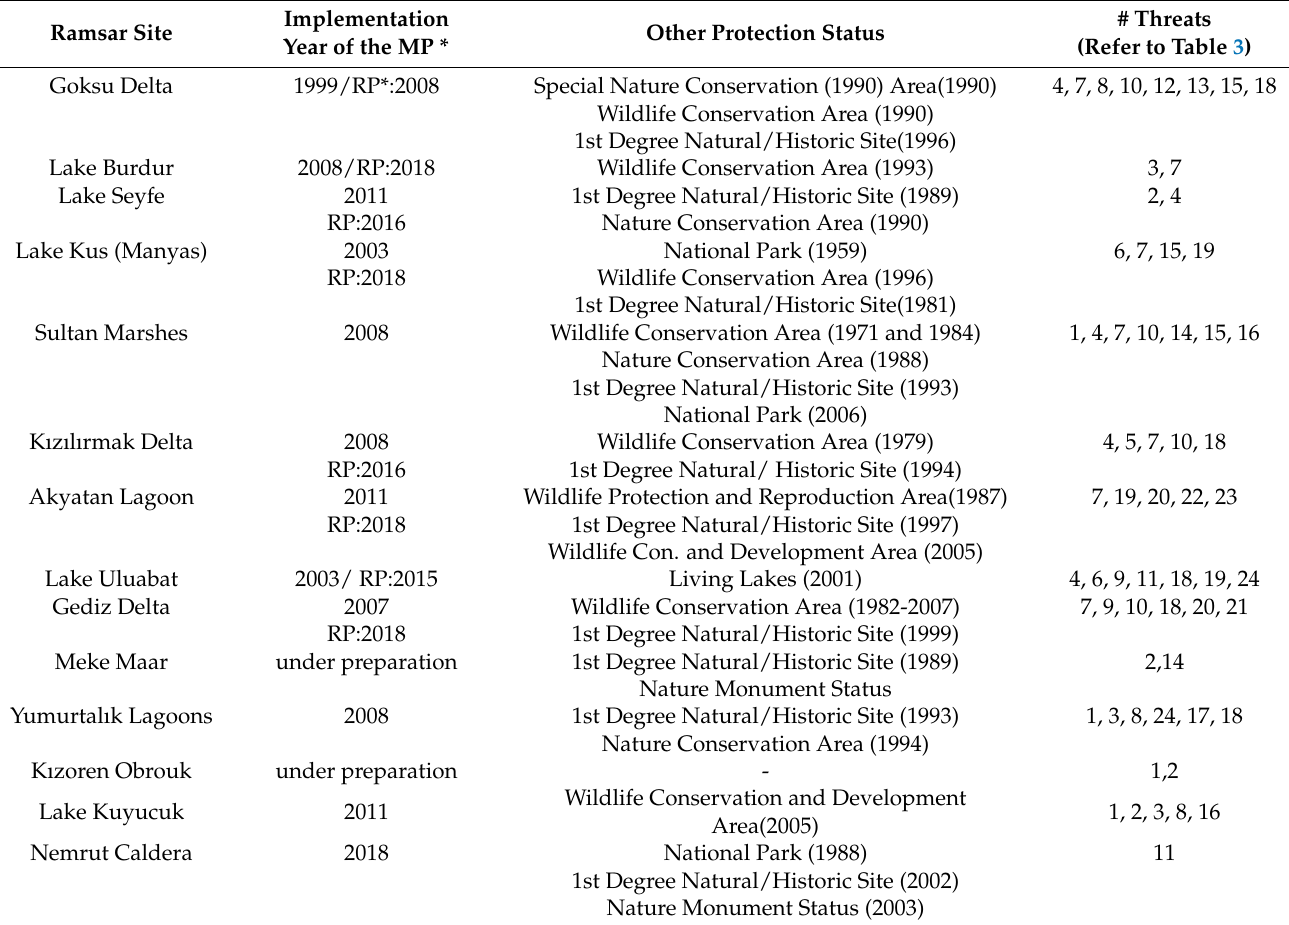
Table 4. Implementation years, other protection status, and threats of Ramsar